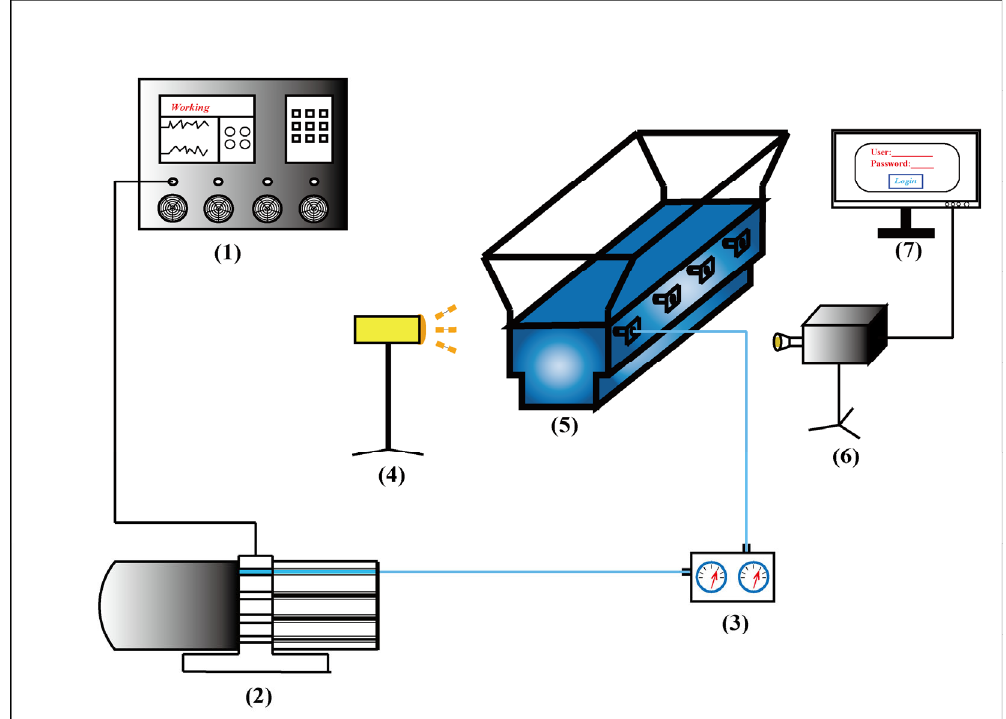
Figure 2. Schematic diagram of water model experimental platform: 1—console; 2—air pumps; 3—flow detector; 4—fill light; 5—water model experimental furnace; 6—high-speed camera; 7—image processing server.